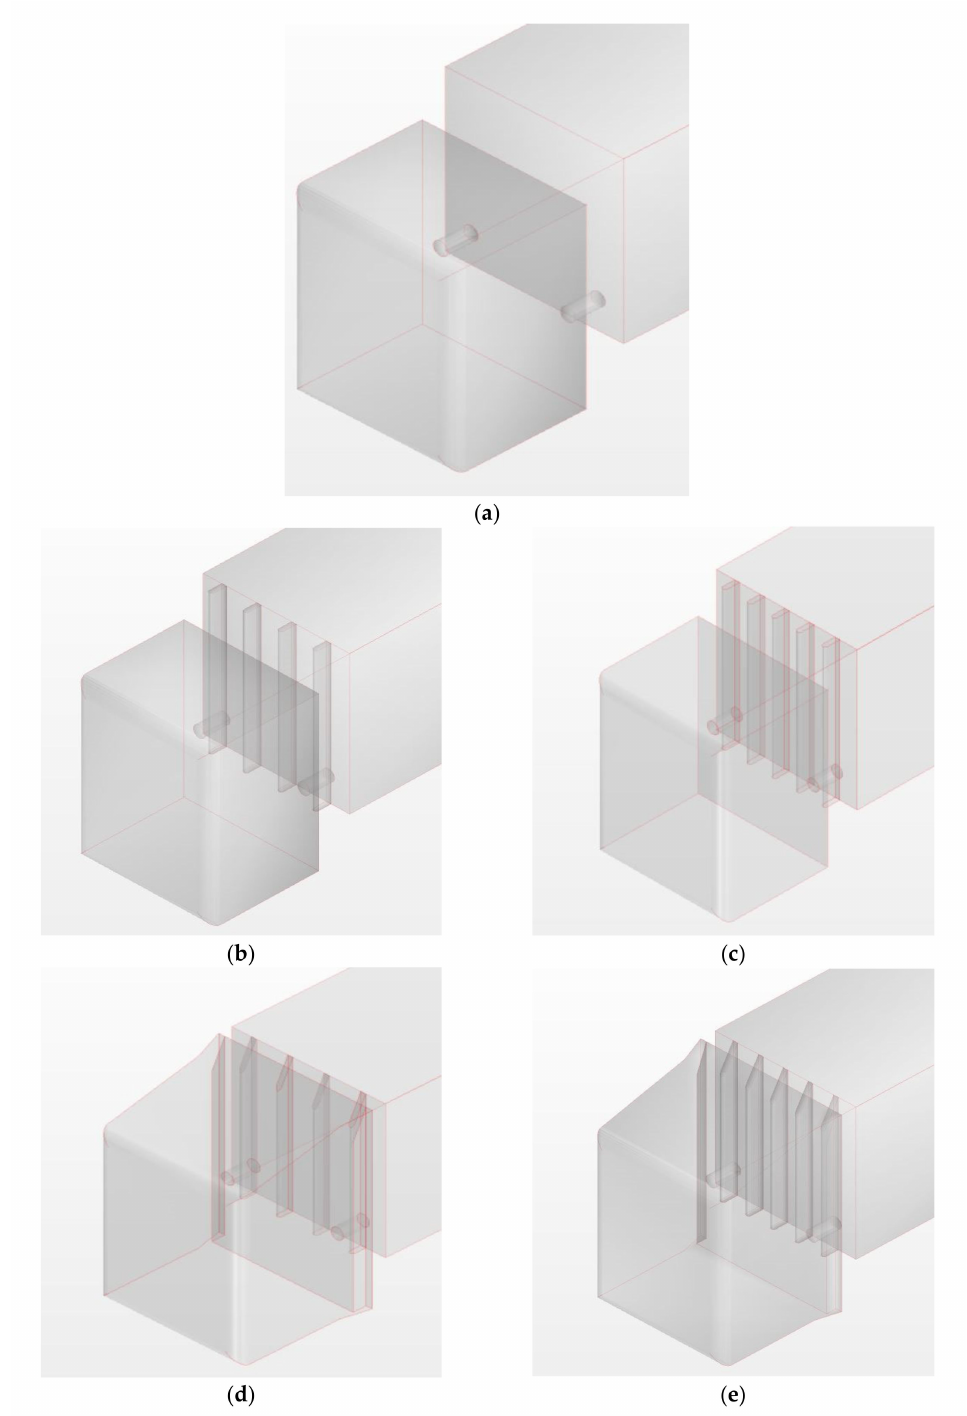
Figure 5. Baseline and four cases with different configurations of drag reduction devices: ( a ) baseline case; ( b ) Case 1; ( c ) Case 2; ( d ) Case 3; ( e ) Case